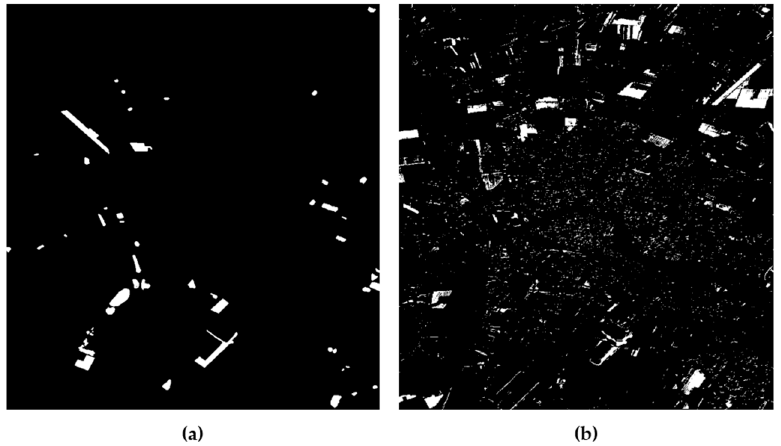
Figure 5. Comparison between ( a ) OSCD and ( b ) CVA ground truth images for test image shown in Figure 3 (change areas are shown in white). Figure 3 (change areas are shown in